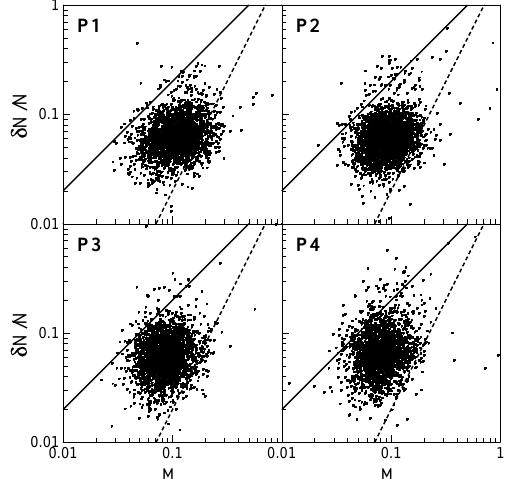
Figure 78: Relative amplitude of density fluctuations vs. turbulent Mach number for polar wind. Solid and dashed lines indicate the 𝑀 and 𝑀 2 scalings, respectively. Image reproduced by permission from Bavassano et al. (2004), copyright